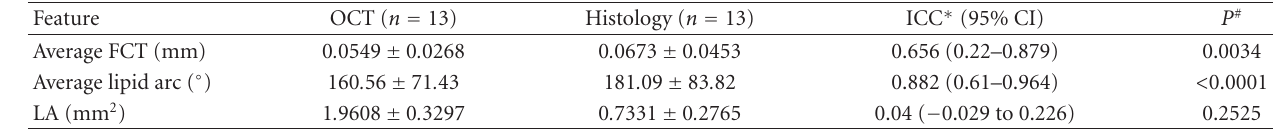
Table 3: Agreement between OCT and histological